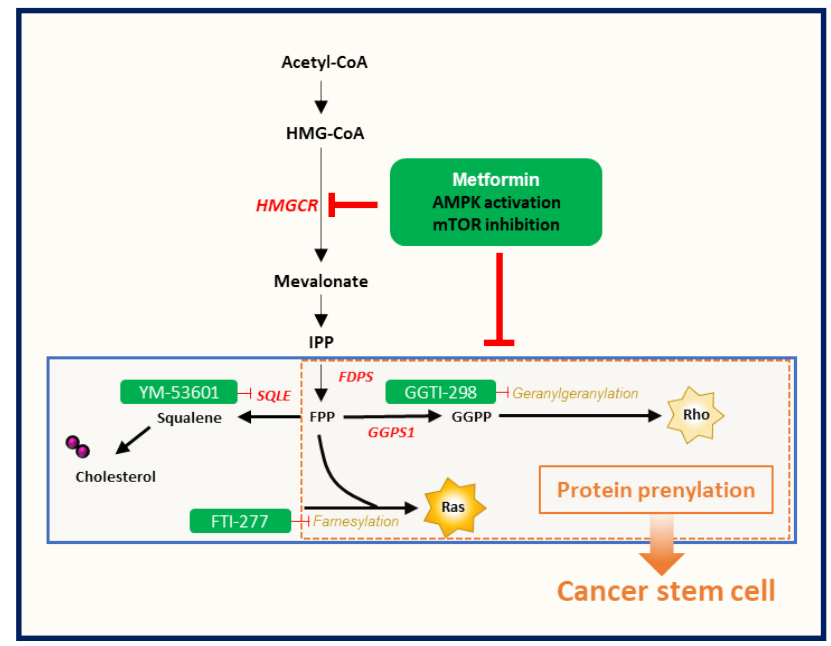
Figure 5. Metformin-induced CSC suppression through AMPK activation and inhibition of protein prenylation by suppression of the mevalonate pathway. prenylation by suppression of the mevalonate